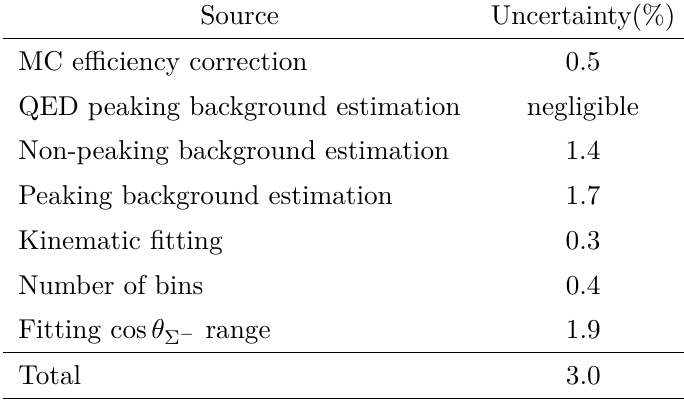
Table 3 . Systematic uncertainties of angular-distribution measurement